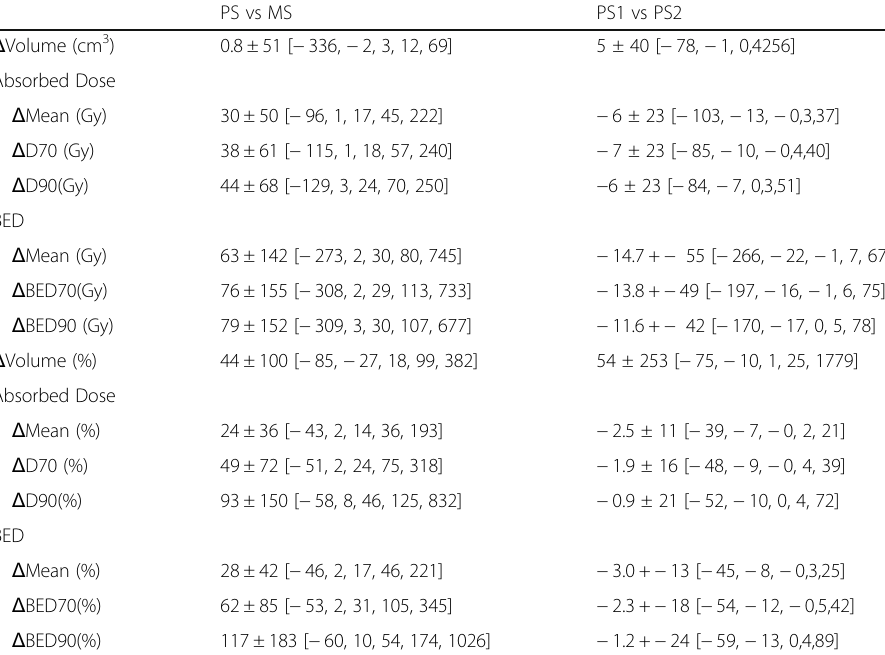
Table 4 Difference in volume and AD/BED metrics at the lesion level when comparing the two segmentation methods and the two realizations of PET-based segmentation PS vs MS PS1 vs